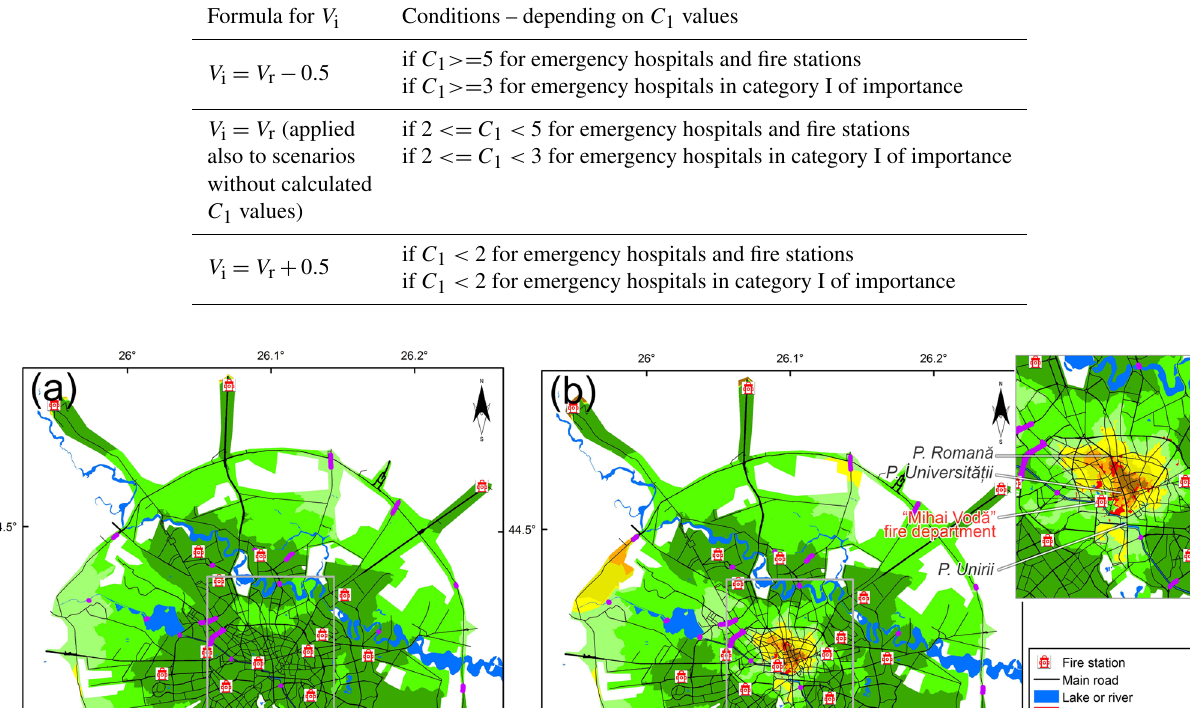
Table 4. Formulas for calculating the index for reclassified vulnerability ( V i ); C 1 intervals are relative to the facility database and study area characteristics.